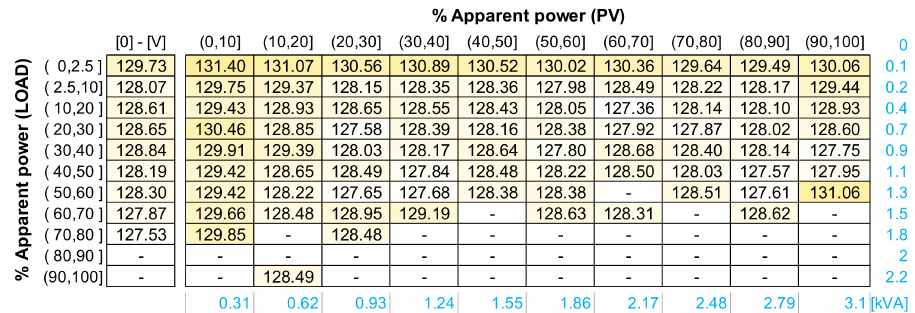
Figure 14. Matrix of average values of Vrms for each scenario of Phase